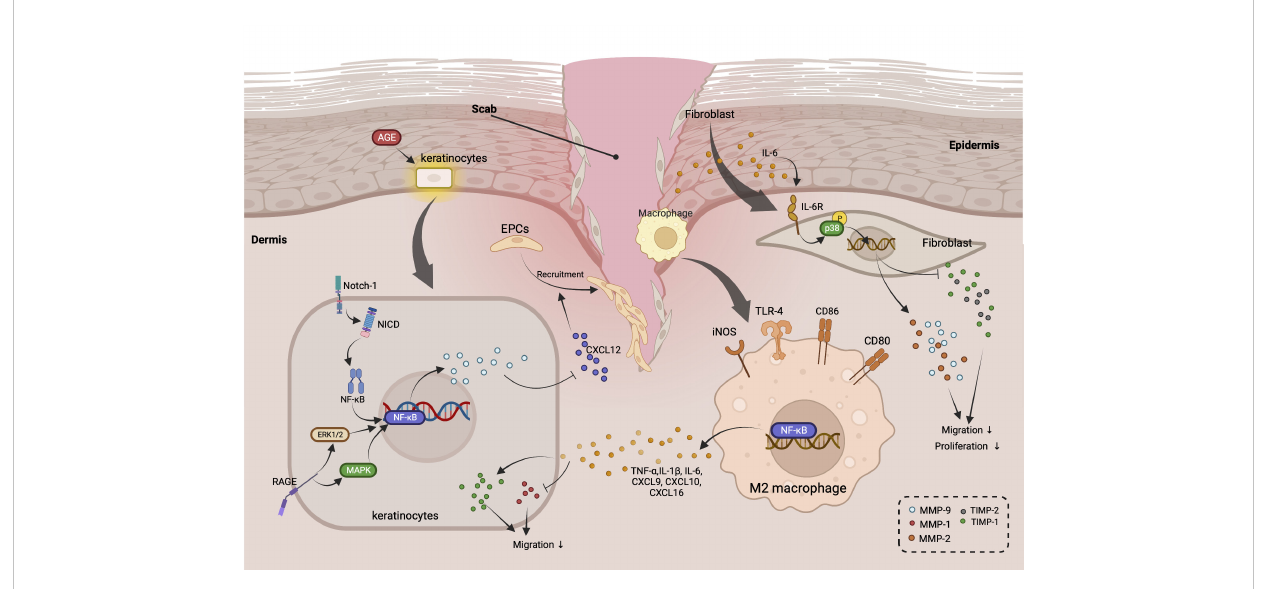
FIGURE 1 Roles of MMPs in regulating in fl ammation-related cross-talks among keratinocytes, macrophage, and fi broblast during diabetic wound healing. (AGEs stimulates the activation of Notch-1/NICD/NF- k B, RAGE/ERK1/2, and MAPK signaling pathways in keratinocytes, which gives rise to the up- regulation of MMP-9. MMP-9 released by keratinocytes suppresses the recruitment of EPCs through down-regulating the expression of CXCL-12. In addition, TNF- a , IL-6, and other pro-in fl ammatory cytokines secretes by M2 macrophage elevate TIMP-1 and reduce of MMP-1, resulting in the suppressed migration of keratinocytes. Intriguingly, IL-6 also inhibits the migration as well as proliferation of fi broblast via promoting the expression of MMP-2 and MMP-9, while decreasing the levels of TIMP-2 through activating IL-6R/p38